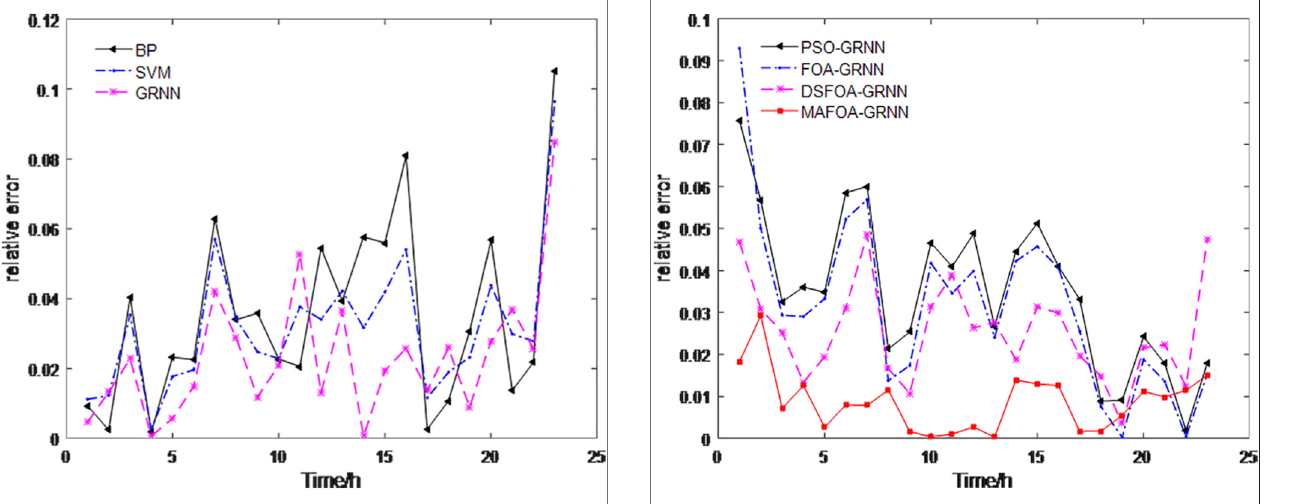
FIGURE 5 | Relative errors of the single models. FIGURE 6 | Relative errors of the hybrid